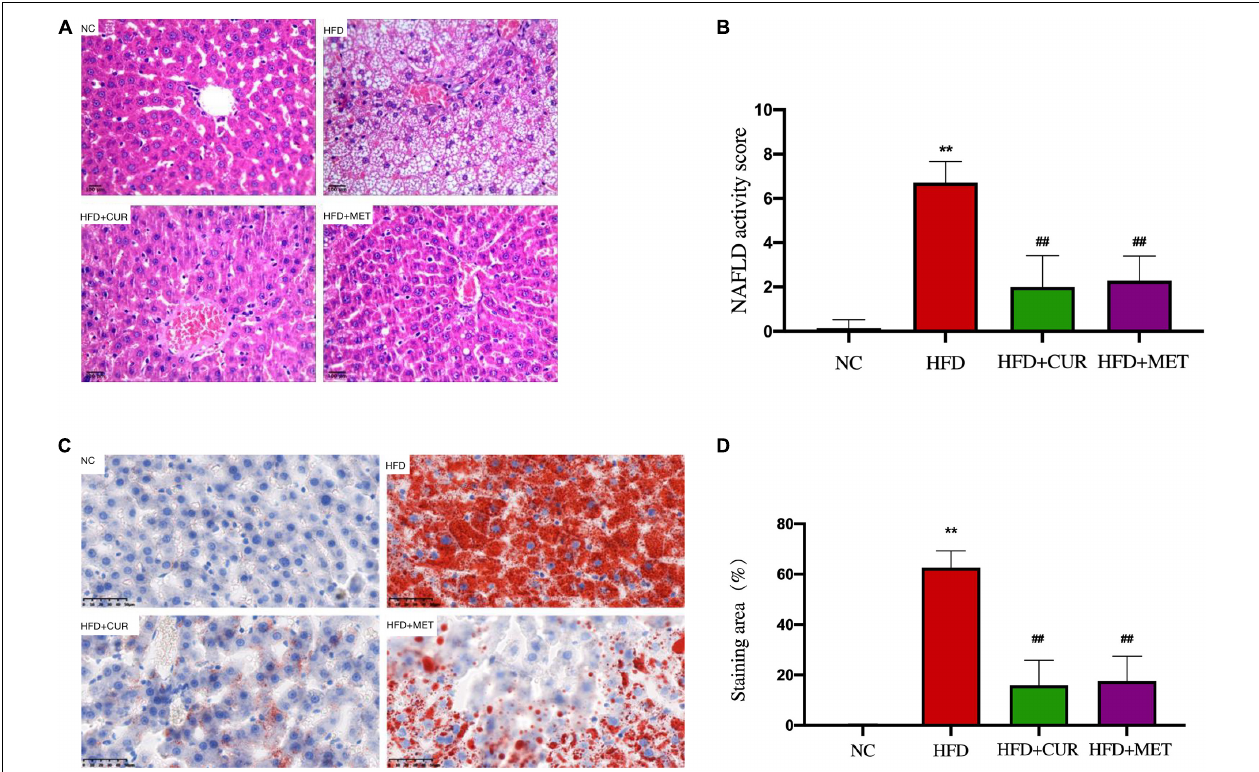
FIGURE 4 | Effects of CUR and MET on HFD-induced hepatic steatosis. (A) HE-stained liver tissue. (B) Score of liver HE staining. (C) Oil red O-stained liver tissue. (D) The quantitative results of the oil red O staining from rats in the NC, HFD, HFD + CUR, and HFD + MET groups. Seven rats per group ( n = 7). Values were presented as the means ± SD for each group. ** p < 0.01 compared with the NC group. ## p < 0. 01 compared with the HFD